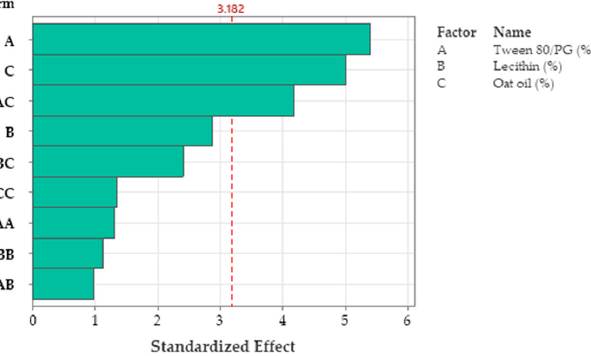
tioned considerations concerning X 1 X 3 interactions deduced from the regression equation, the Ds response is specifically sensitive to both variables. The highest sensitivity is at- tributed to the X 3 variable, and the contour lines oriented through the Y axis can be ob- served. Therefore, a red domain is specific for particles with a diameter under 5 nm, which can be formed when X 1 is settled to a low level and associated with a low level of X 3 . In the same manner, at a maximum level of X 1 , small particles were formed when X 3 was settled at any of the three levels of variation. Finally, setting up the X 1 and X 3 parameters at a medium level is favorable to attain small particles. An increase of X 3 to the maximum level, using medium levels of X 1 , will sustain the obtaining of particles in a larger domain of up to 40 nm. To conclude, concentrations of Tween 80/PG of 40% are required in order to attain small particles, if the oil phase is considered to be 2%, as well as in the case when the system contains a medium concentration of stabilizer mixture of 30%, prepared with small, medium, or a maximum level of oil phase. From a tridimensional perspective, Figure 18 emphasizes the response surfaces for Ds in accordance with both cases previously exemplified. In the first case related with the Y 2 variation as a function of Tween 80/PG (%) and lecithin (%), a surface in gradient color—case (a), and a wireframe plot—case (b) was projected. On the surface plot can be seen a 3D variation of Ds as function of Tween 80/PG (%), in the sense of minimization from a lighter green shade to a darker tone on the X axis direction, without significant influence of the lecithin level. Moreover, the wireframe model interprets these effects due to the embossed view presented with maximum and minimum points.